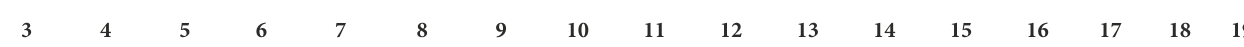
TABLE 2 Descriptive statistics and interitem correlations for key study